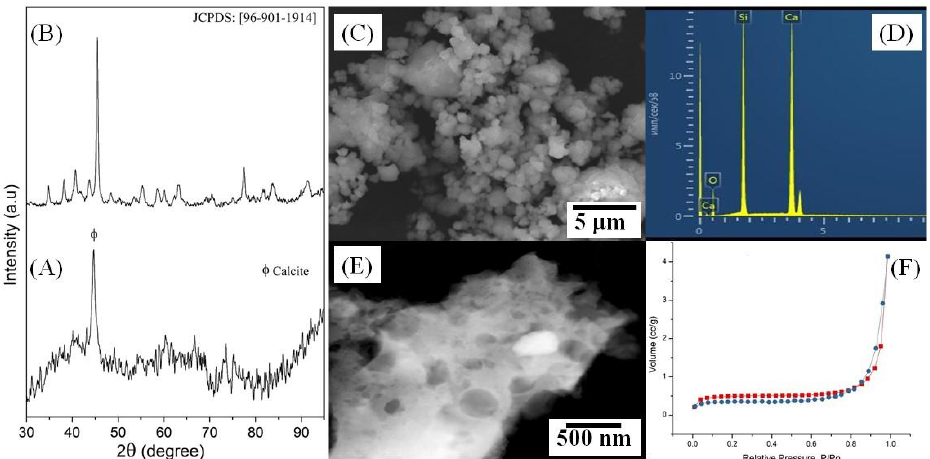
Figure 2. XRD patterns of combusted precursor ( A ) and wollastonite calcined at 800 °C for 2 h ( B ). SEM image ( C ); EDX spectrum ( D ) and HAADF-STEM ( E ) image of pure wollastonite. Nitrogen adsorption–desorption isotherm of pure wollastonite ( F ).